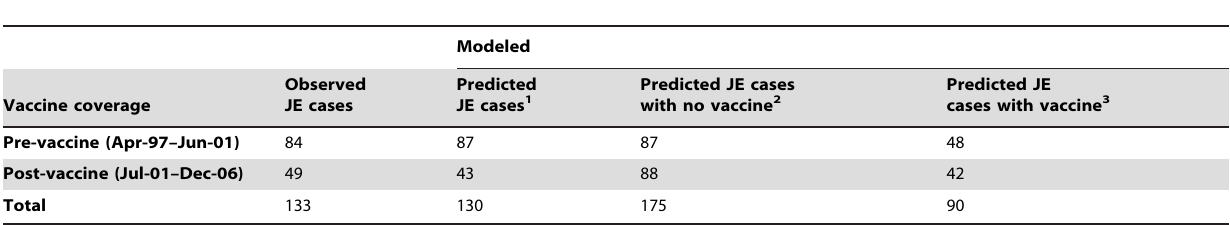
Table 3. Sum of observed and predicted Japanese encephalitis cases modeled with and without vaccination over the 10-year surveillance